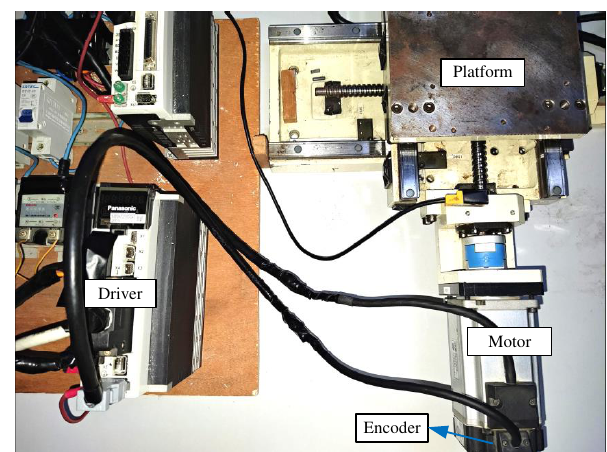
Figure 14. Experiment